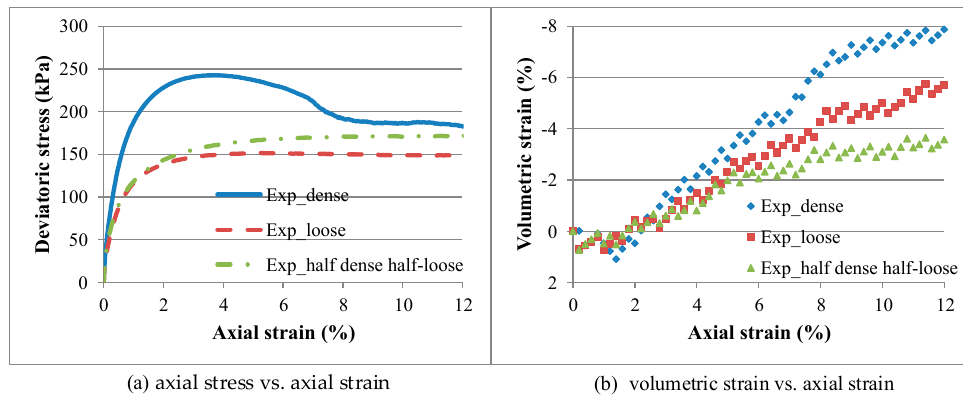
Figure 6. Experimental behavior curves ( a ) axial stress vs. axial strain ( b ) volumetric strain vs. axial strain for the dense, loose, and half-dense half-loose specimens.